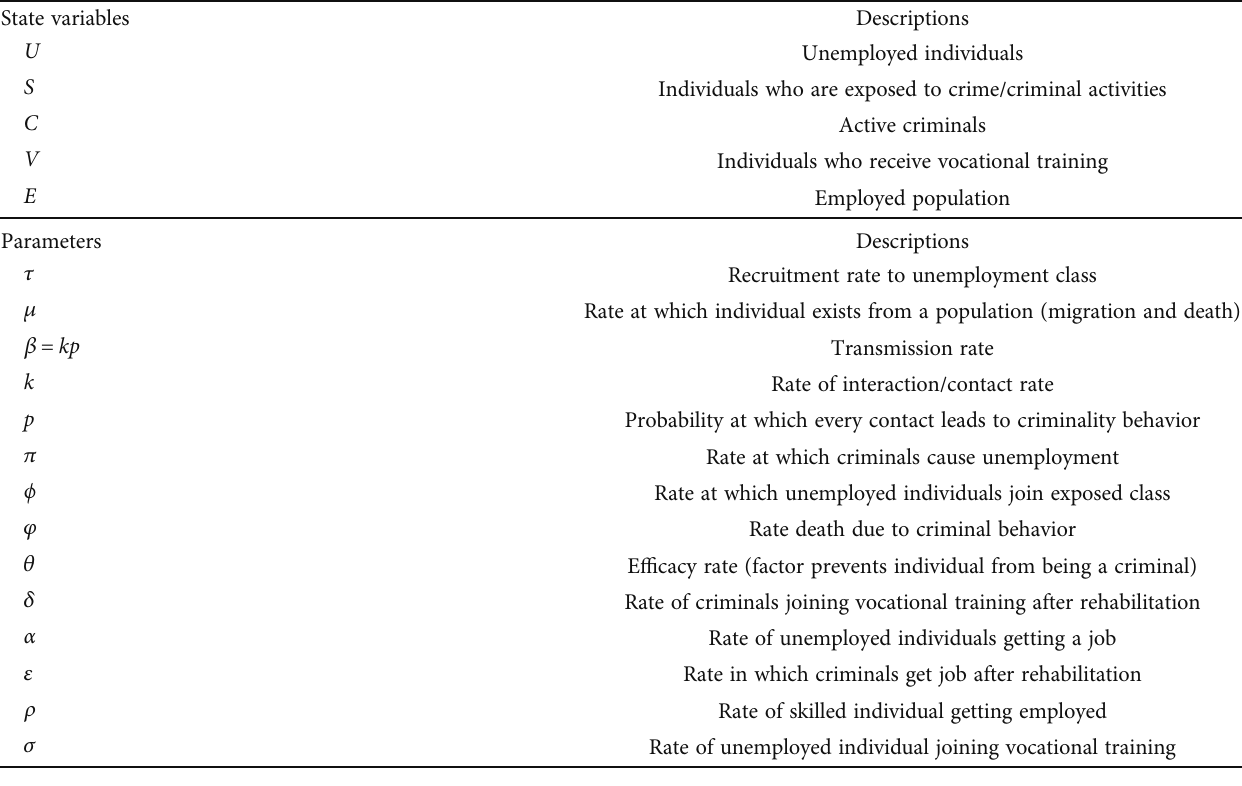
Table 1: Description of state variables and parameters in the crime model.